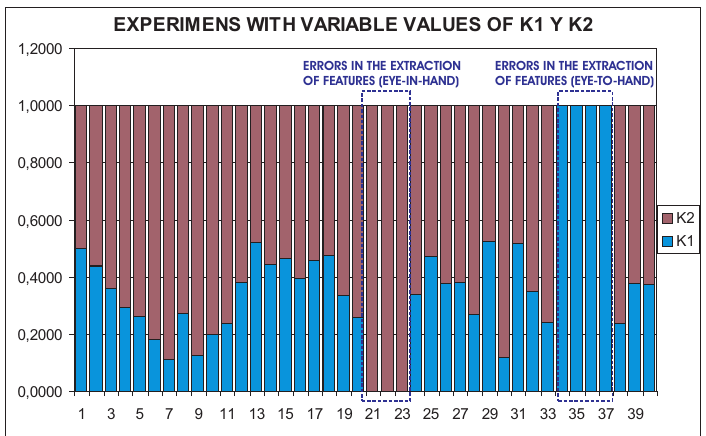
and k with forced error in the extraction of features. 1 2